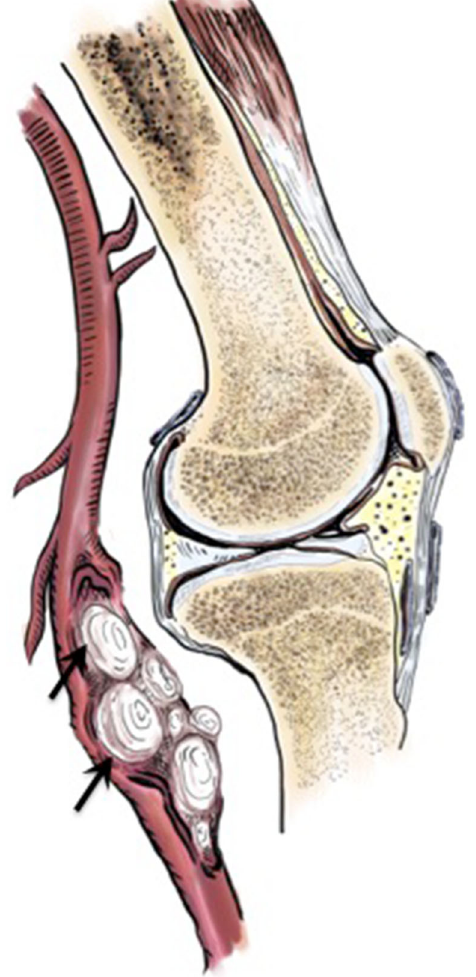
Fig. 2 Drawing showing cystic adventitial disease of the popliteal artery. Eccentric cystic lesions arising from the anterior wall of the popliteal artery are shown ( arrows )